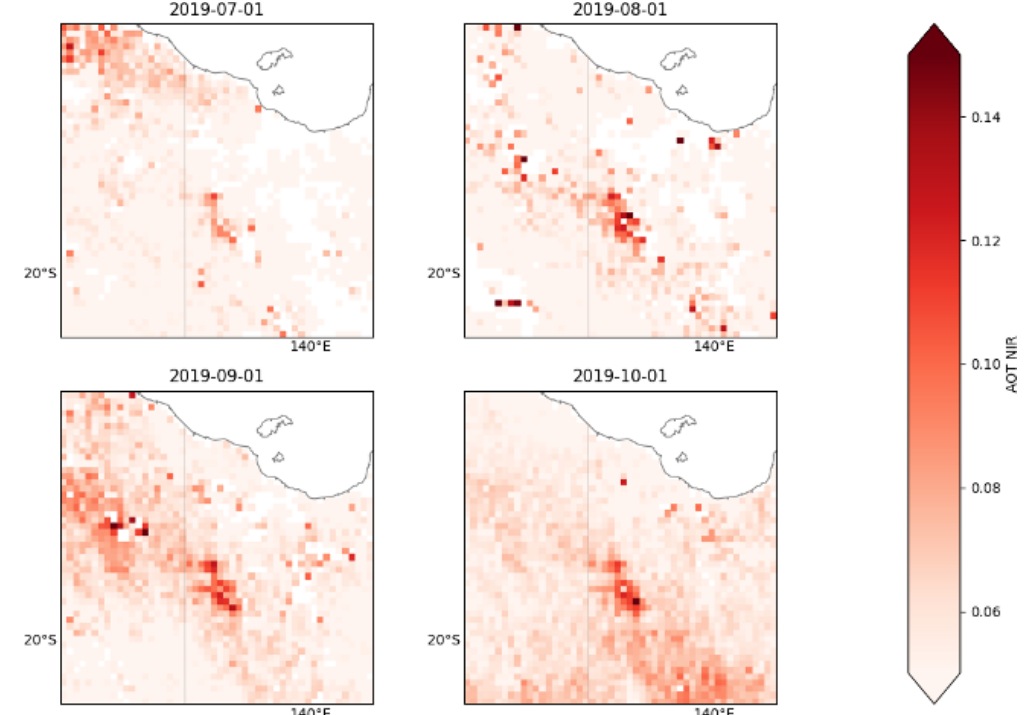
Figure 18. Aerosol optical thickness (AOT) in the near-infrared (NIR) band over Australia, as provided by TROPOMI. Maps display averages for the same windows as shown in Fig.